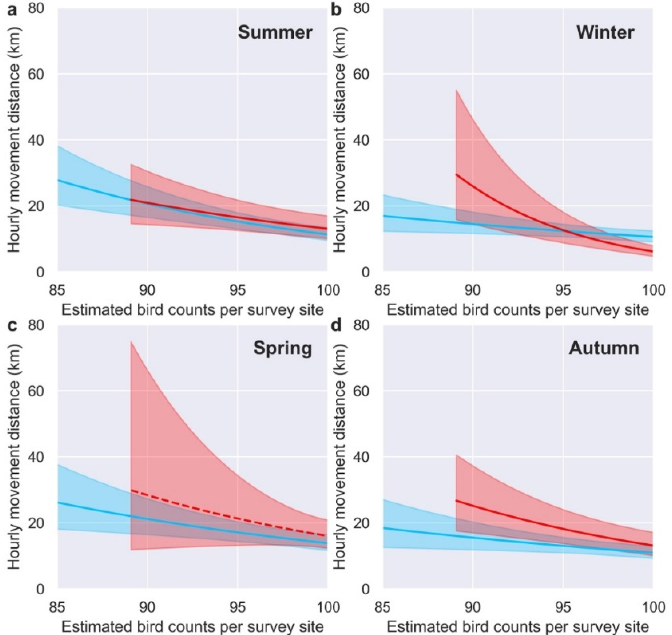
Figure 4. Effects of seasons and relative population abundance on maximum hourly movement distances of American White Pelicans. Panels show ( a ) summer, ( b ) winter, ( c ) spring migration, and ( d ) autumn migration. Blue and red colors represent wintering groups at Northern and Southern Gulf of Mexico, respectively. Polygons represent 95% confidence intervals of the maximum hourly movement distances.